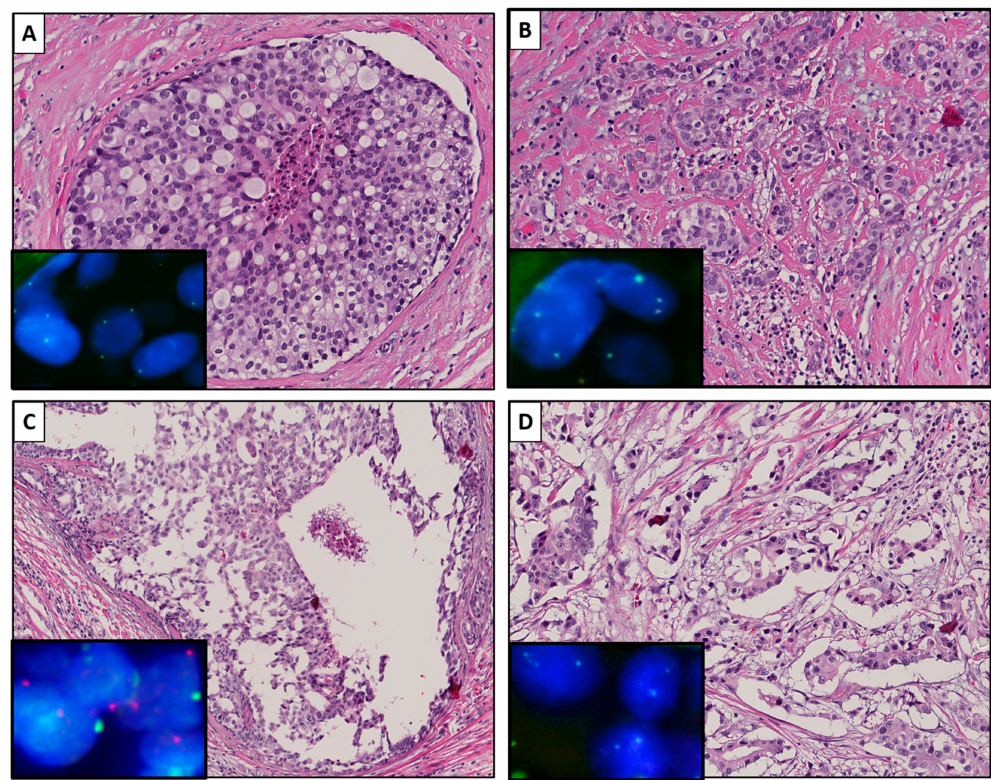
Figure 1. Representative images of a male breast cancer (BC) case with a concordant loss of Y-chromosome (LOY) status between ductal carcinoma in situ (DCIS) ( A ) and invasive BC ( B ) and a case with a discordant LOY status between DCIS ( C ) and invasive BC ( D ). Hematoxylin and eosin staining, at a 15 × magnification and insets of the corresponding XY fluorescent in situ hybridization (FISH) images at a 63 × magnification. The cell nuclei are depicted in blue (dapi), the X-chromosome is depicted in green (Fluorescein-5-isothiocynate;FITC), and the Y-chromosome is depicted in red (Texas